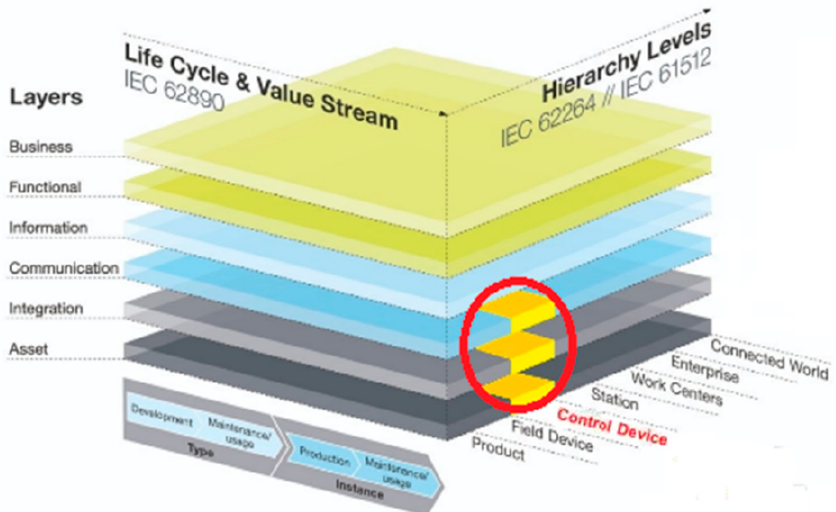
Figure 2. Relationship between the reference architecture model for Industry 4.0 (RAMI 4.0) layers and the open-source control